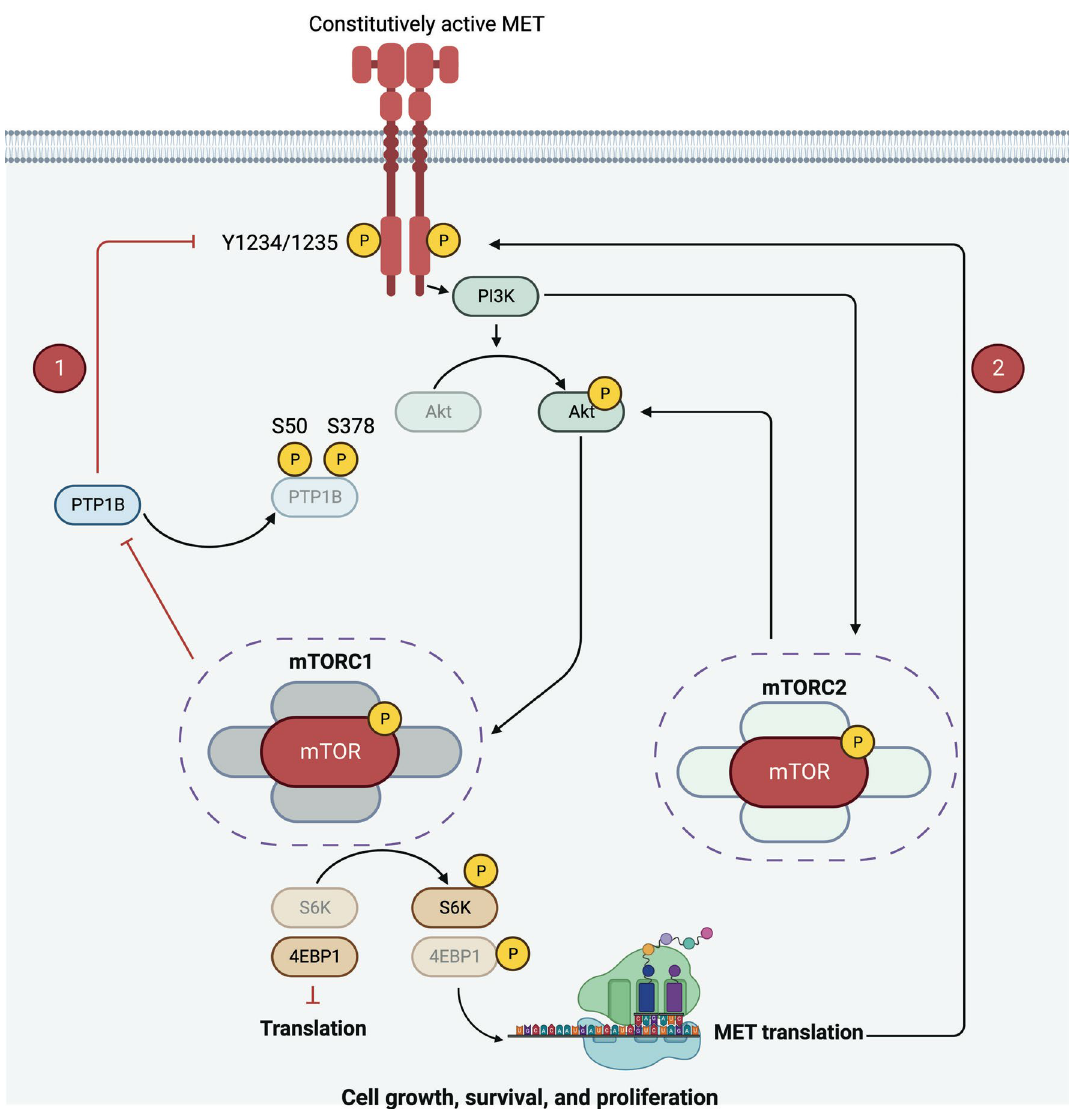
Figure 5. Schematics of the mechanism of the ‘flare’ effect. JNJ-605 discontinuation leads to the activation of the AKT/mTOR pathway, which drives (1) PTP1B inactivation by phosphorylation on S50 and S378, and